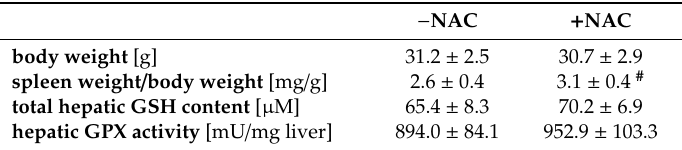
Table 1. E ff ects of chronic NAC treatment on the body and spleen weight, the hepatic GSH content, and hepatic GPX activity in vivo. Four-week-old male mice (C57BL / 6Jrj) chronically received NAC for 20 weeks via the drinking water (1 g NAC / 100 mL). The data are shown as mean ± SD ( n = 10) and were calculated by unpaired t-test. # p < 0.05 vs. − NAC (NAC e ff